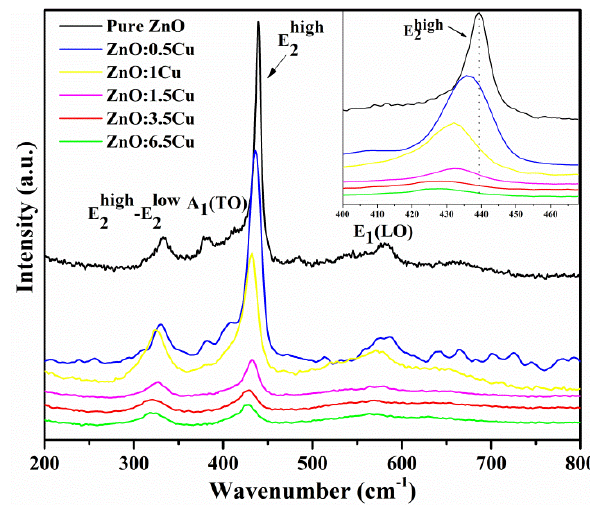
Figure 4. Raman spectra of the calcined pristine ZnO and ZnO:XCu model catalysts, X = 0.5, 1.0, 1.5, 3.5, 6.5. Table 1. The wave number of E high and ZnO:XCu model catalysts.